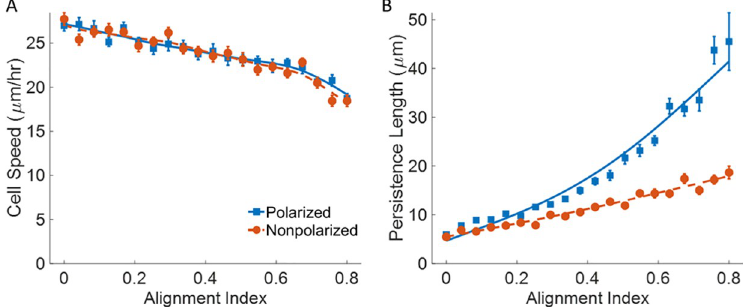
Fig 3. Effect of fiber alignment. Plots for v avg and L p as a function of increasing alignment index A) Cell speed B) Persistence length. C gel = 3.7 mg/ml, ρ i = 6 sites/monomer, ρ fiber = 1.0 x 10 − 3 fibers/ μ m 3 , and t search = 16s. Simulation time = 48hrs. n = 20. Solid blue lines are polarized cells ( ◼ ), dashed red lines are nonpolarized cells ( ● ). Error bars represent ±